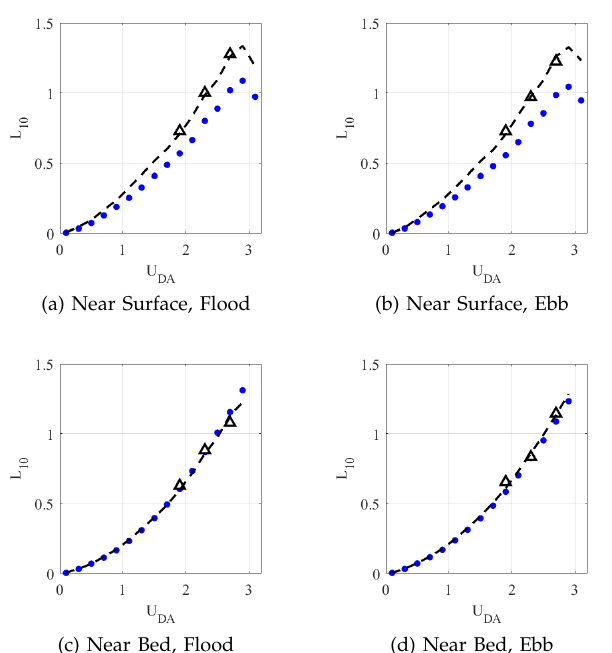
Fig. 9. Normalised DEL for the range of flow speeds for each turbine position and tide. Predicted mean profiles and constant turbulence (blue dot), Measured varying profiles and turbulence (black triangle), estimated loads from measured varying profiles (black